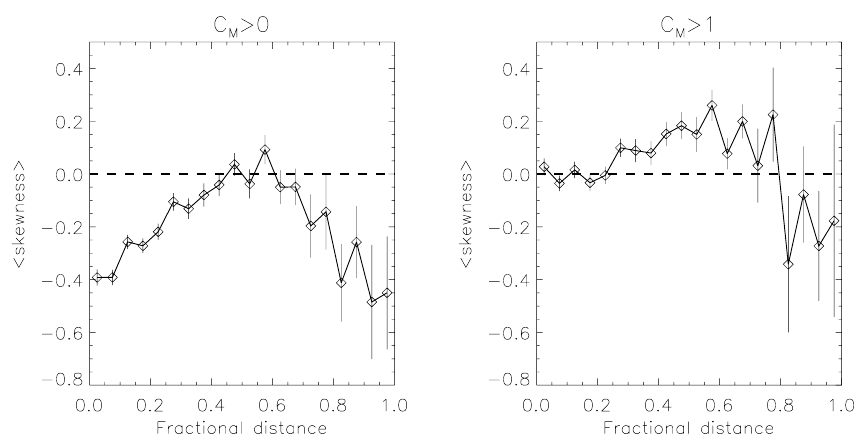
Fig. 4. Average skewness as a function of the fractional distance F for C M > 0 (left) and C M > 1 (right). The error bars are proportional to √ σ/ N where σ is the standard deviation and N is the number of mirror events in each 1F = 0 . 05 bin ( N min = 17 and N max = 709 for C M > 0 and N min = 7 and N max = 301 for C M >